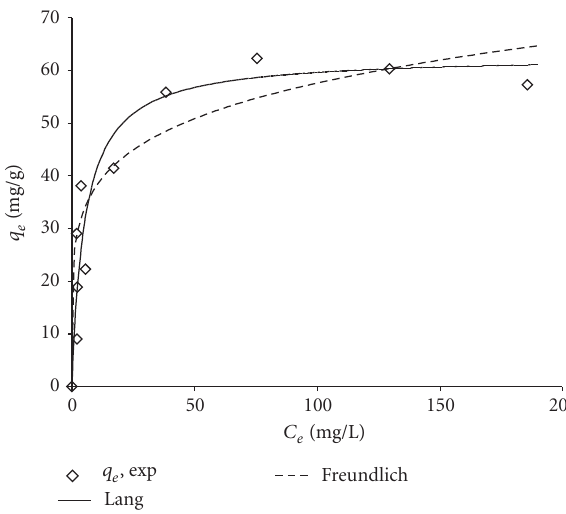
F 5: Equilibrium curve for adsorption of MB onto PLC at 303K (agitation speed = 200RPM, dosage= 2g/dm